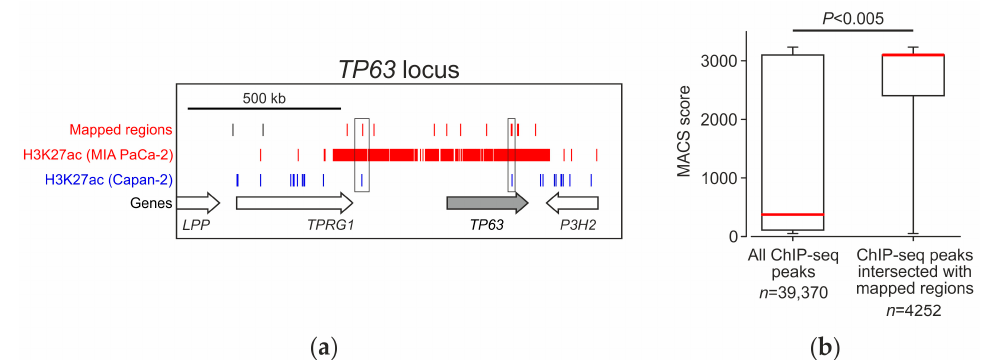
Figure 4. Analysis of the location of the mapped regions relative to H3K27ac-rich genomic regions. ( a ) Location of selected fragments in the vicinity of TP63 gene expressed in Mia PaCa-2 cells and not expressed in Capan-2 cells. Mapped fragments preferentially overlap with the H3K27ac enriched regions in MIA PaCa-2 cells (highlighted in red). Fragments (2 of 14) that overlap with H3K27ac enriched regions in both MIA PaCa-2 and Capan-2 cells are boxed. ( b ) The mapped fragments tend to be localized in the MIA PaCa-2 H3K27ac-rich chromatin regions. “Box and whiskers” plot displays the distribution of ChIP-seq peaks of H3K27ac in MIA PaCa-2 by mapped read density (MACS score, Model-based Analysis of ChIP-Seq). Mapped regions overlap predominantly with regions of the genome with high H3K27ac content (Mann–Whitney test, min-max range). “ n ” is the number of ChIP-seq peaks. Red line indicates the median value.